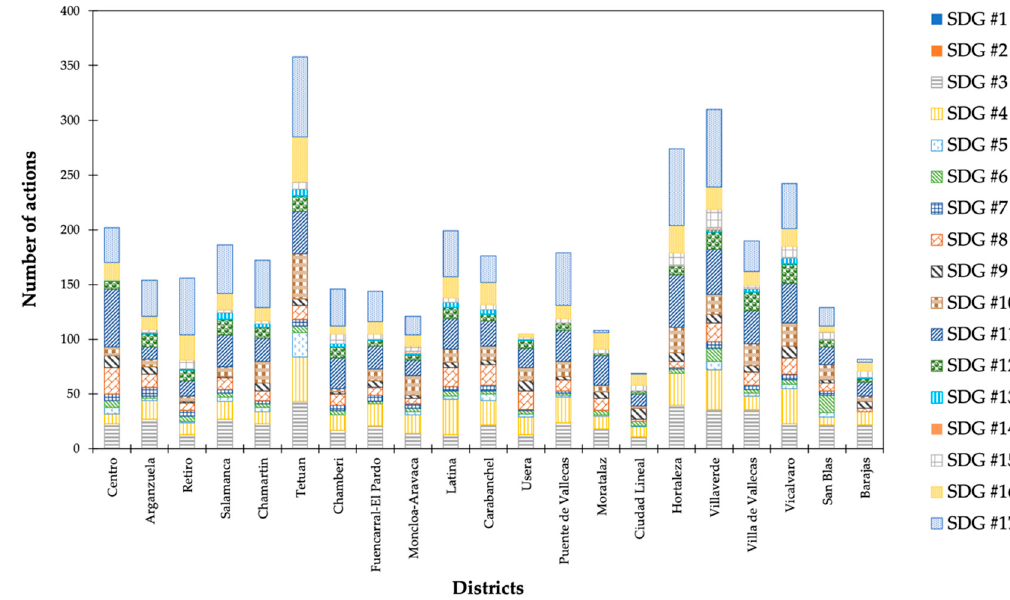
Figure 7. Assignment of actions by borough and SDG (Source: Figure 7 . Assignment of actions by borough and SDG (Source: author).